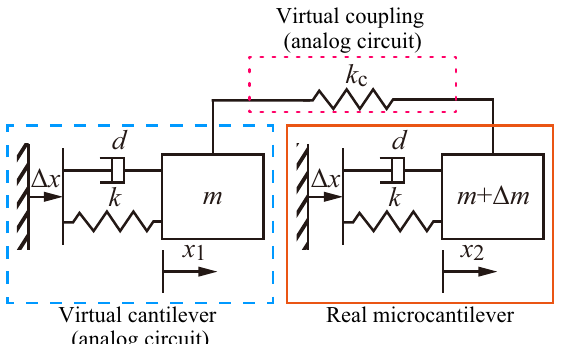
Figure 1. Discretized analytical model of the coupled real and virtual cantilevers. The left virtual cantilever enclosed by the dashed line and the virtual coupling part between cantilevers enclosed by the dotted line are implemented with an analog circuit. The right cantilever enclosed by the solid line is a real